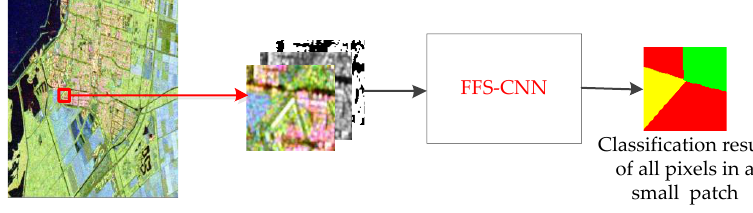
Figure 3. Multi-pixel simultaneous classification of PolSAR images.